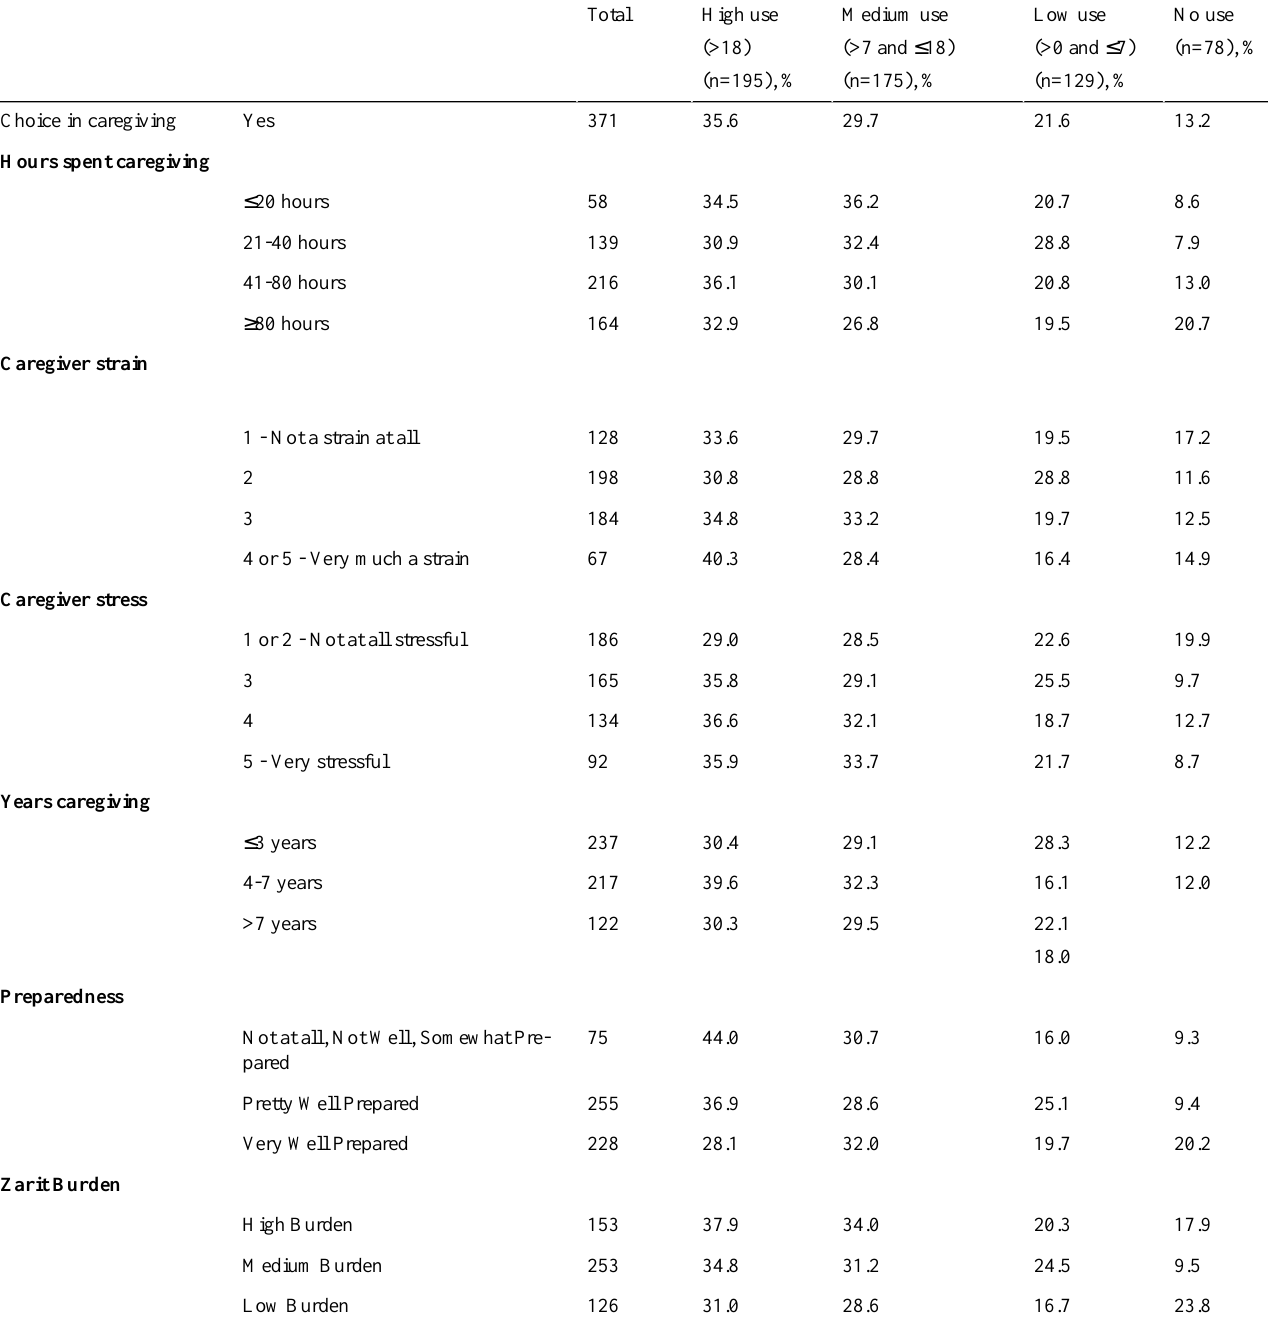
Table 4. Results of bivariate analysis of caregiving behaviors and frequency of total app use in the survey